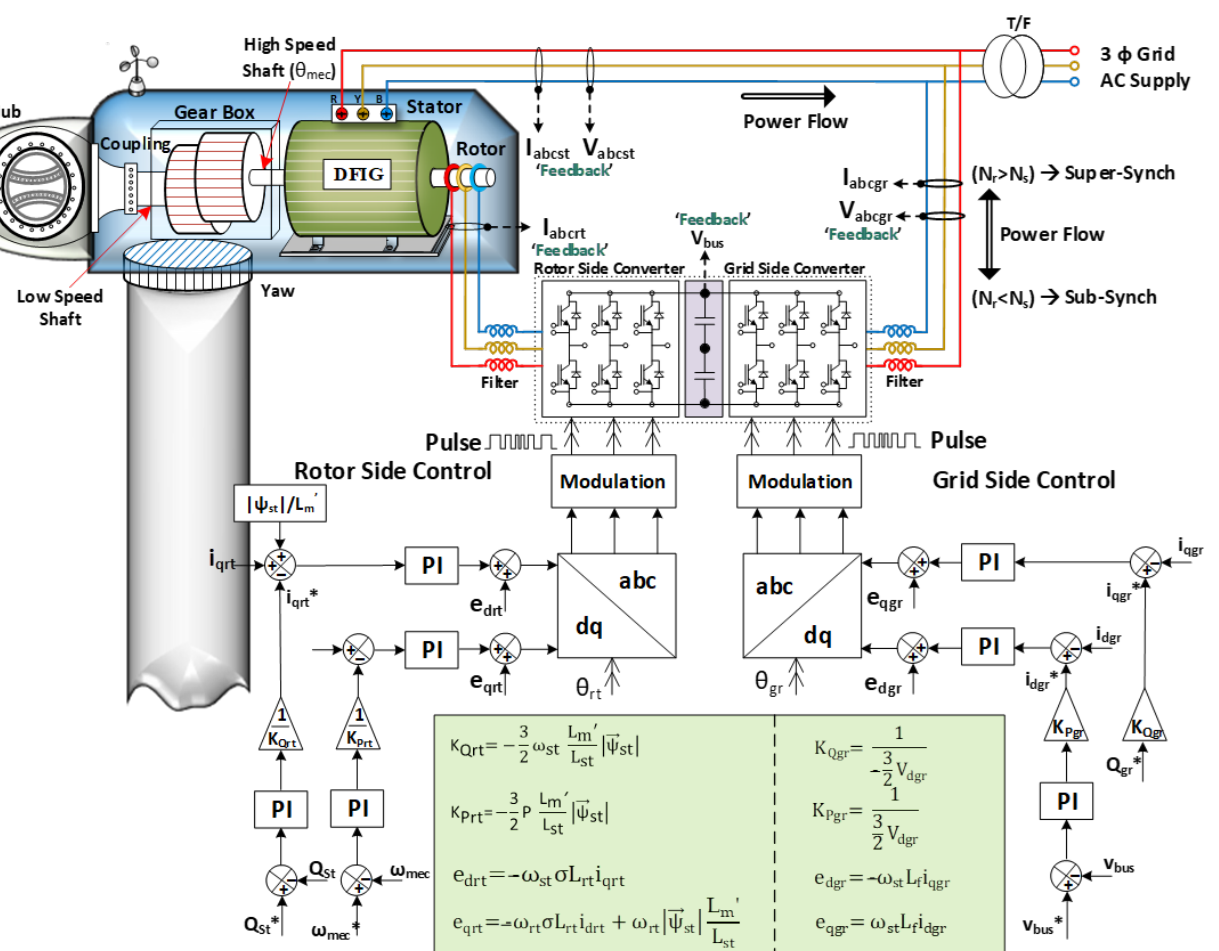
Figure 1. Configuration of DFIG wind turbine with RSC and GSC control.